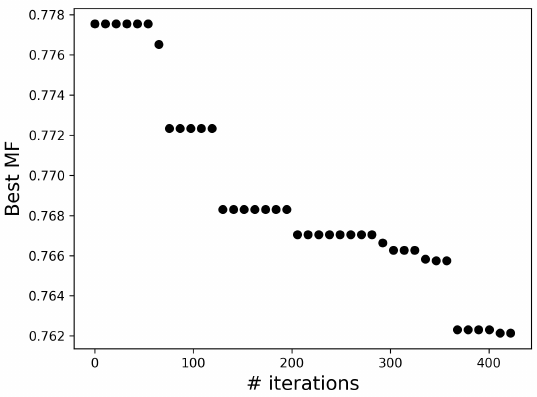
Figure 13. Evolution of the best particle as a function of the number of iterations.